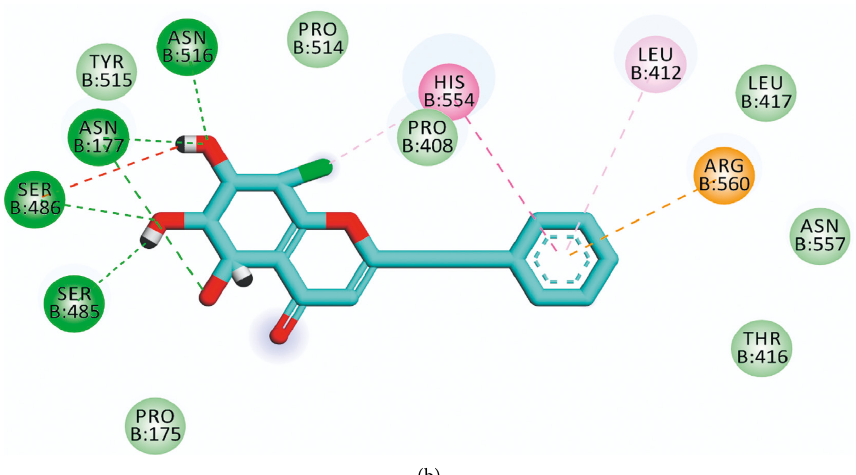
Figure 7: (a) 3D and (b) 2D images of the docked compound 637 into the active site of SARS-CoV-2 helicase.